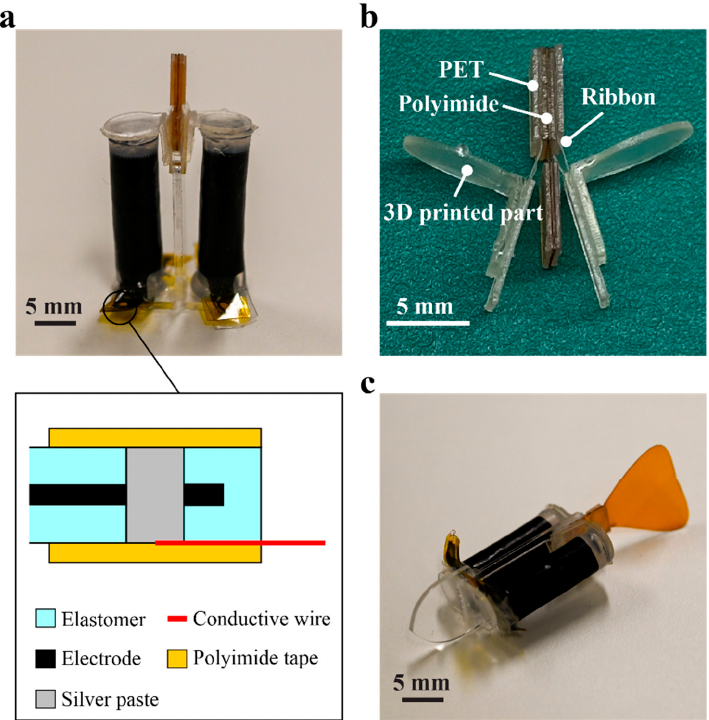
Figure 5. ( a ) Fabricated antagonistic actuator and its electrical connection. ( b ) Hinge mechanism. ( c ) Fabricated fish-type robot using the actuator. Table 1. Model parameter of the